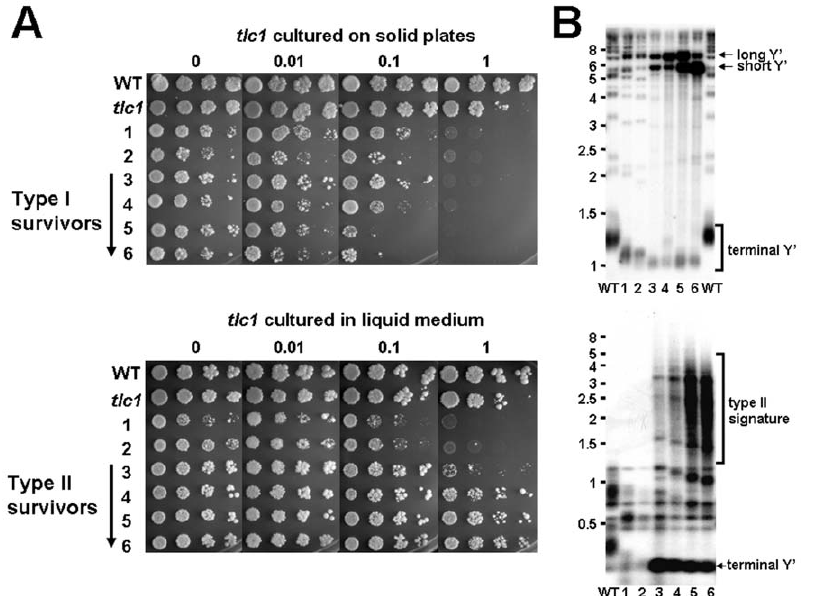
Figure 3. Dynamics of bleomycin response during tlc1 mutant outgrowth. ( A ) Spot test analysis of serial 5-fold dilutions of the indicated strains on YEPD or YEPD containing indicated concentration of bleomycin. tlc1 spore colonies were passaged either by restreaking on solid plates (top) or repeat dilutions in liquid medium (bottom). ( B ) Southern blot analysis of the Xho I- (top) or four-base cutter (bottom)-digested genomic DNA isolated from the strains in ( A ) probed with telomere sequences. The numbers in both panels indicate numbers of restreaking or dilutions. The arrows in (A) indicate the rise of type I (top) or type II (bottom) survivors.